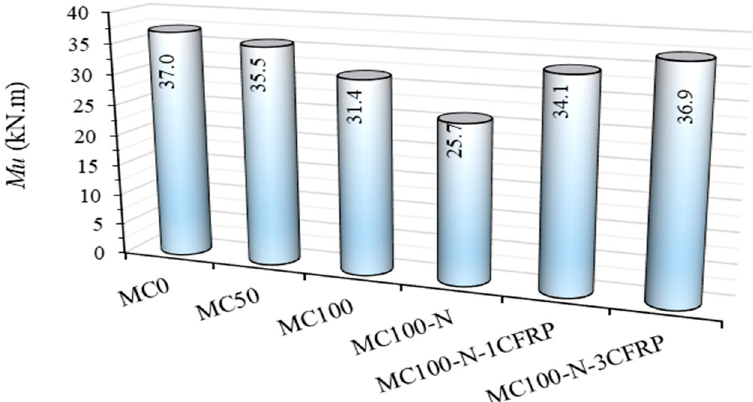
Figure 12. Moment vs. mid-span de fl ection relationships of the CFRP strengthened RCFSST speci- mens.